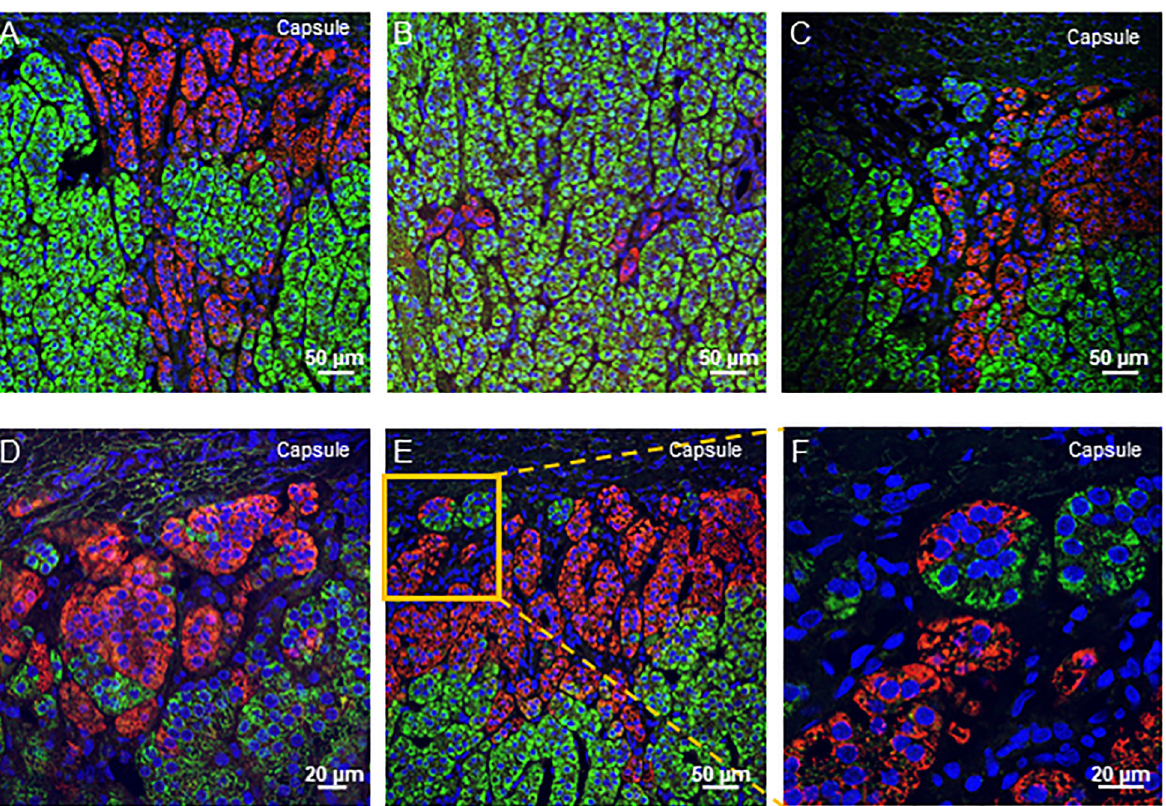
Fig 3. CYP11B1 and CYP11B2 positive cells are interwoven throughout the adrenal cortex. (A-F) Double immunofluorescence staining reveals the occurrence of CYP11B2 positive cells (red) in the ZF (CYP11B1 positive; green) in the adrenal cortex of a 49-year-old man. (A-B) In the inner cortex, clusters of CYP11B2 positive cells are intermingled with CYP11B1 expressing cells. (C-F) Both CYP11B1 and CYP11B2 positive cells participate in the formation of baskets found in the histological ZG.